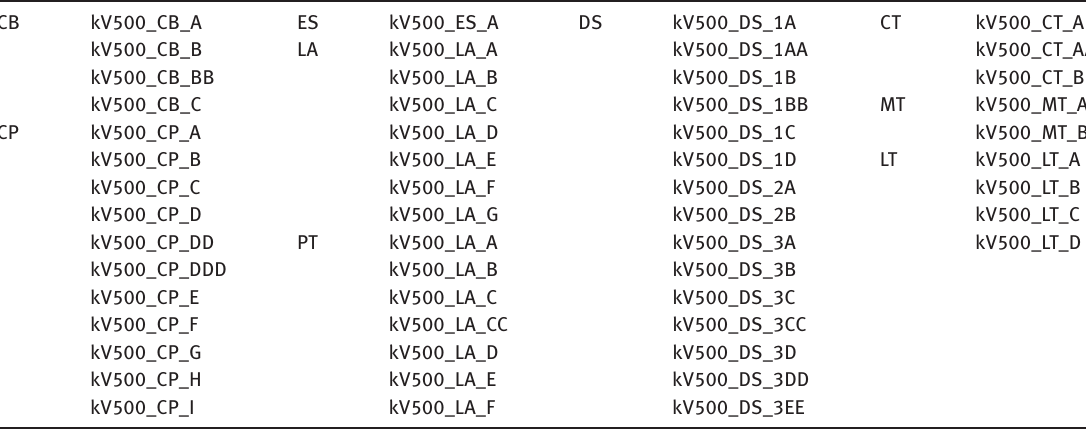
Table 2: Types and Models of Substation Equipment.